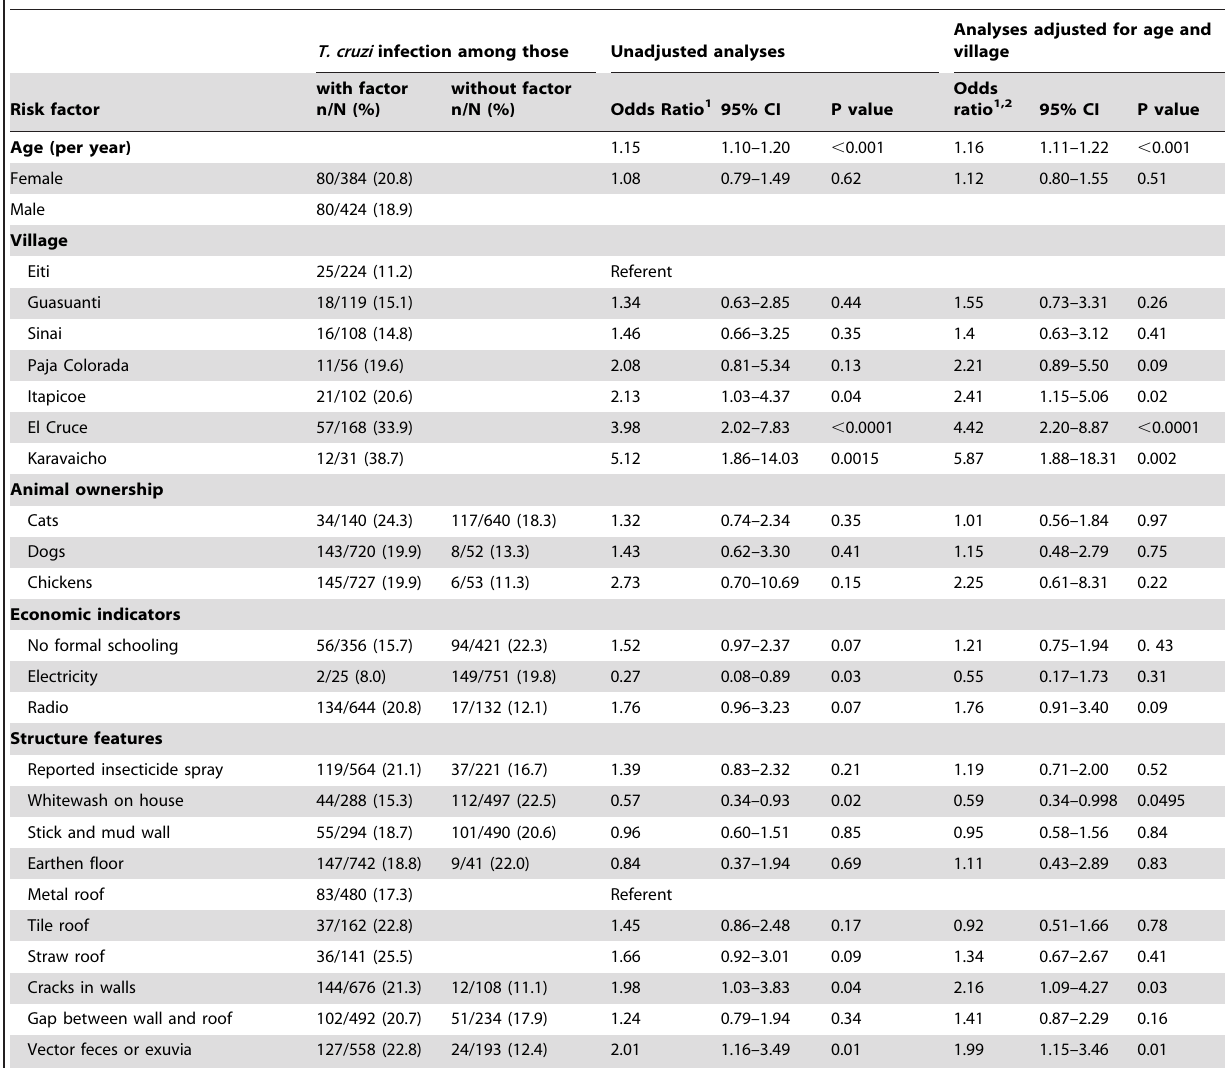
Table 3. Risk factors for T. cruzi infection among children 2–15 years old.